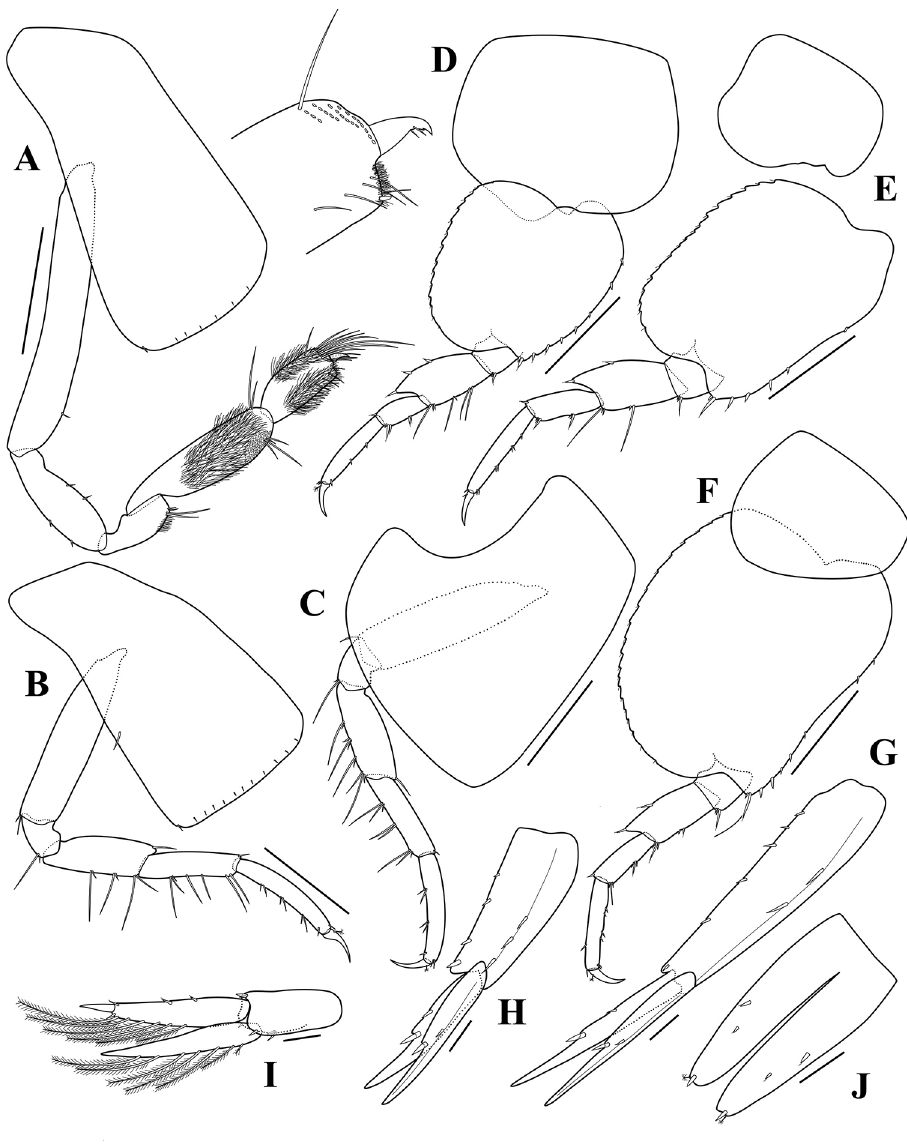
Figure 3. Opisa parvimana sp. nov. holotype, adult male, MARBK-300, 8.3 mm A gnathopod 2 B pere- opod 3 C pereopod 4 D pereopod 5 E pereopod 6 F pereopod 7 G uropod 1 H uropod 2 I uropod 3 J telson. Scale bars: 0.4 mm ( A–G ), 0.1 mm ( H–J ). Antenna 2 (Fig. 4C) slender, much shorter than that of male, peduncular articles 3–5 shorter than those of male; flagellum 7-articulate, calceoli